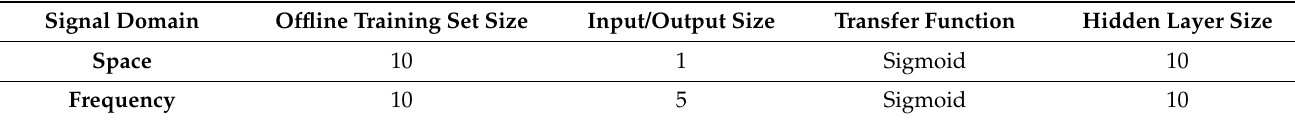
Table 4. Parameter setting of the OS-ELM-based interference activity prediction